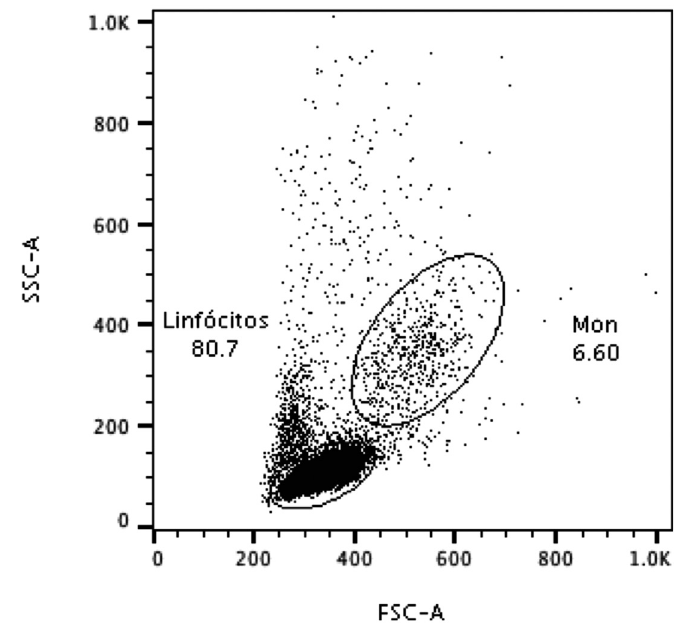
Figure 1- Representative lymphocyte and monocyte populations gated in the size versus granularity dot plot